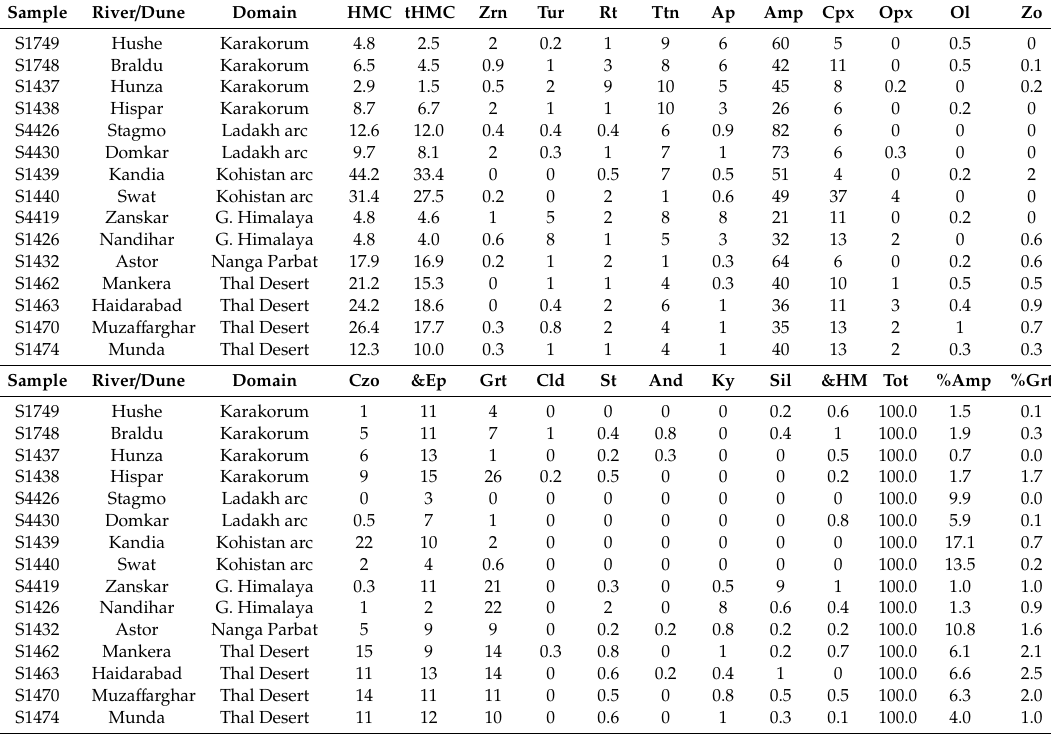
Table 1. Heavy-mineral assemblages in river sands of the Upper Indus catchment (end-member sources) and eolian dunes of the Thal Desert (sediment sink) performed by semi-automated Raman spectroscopy. Sample River / Dune